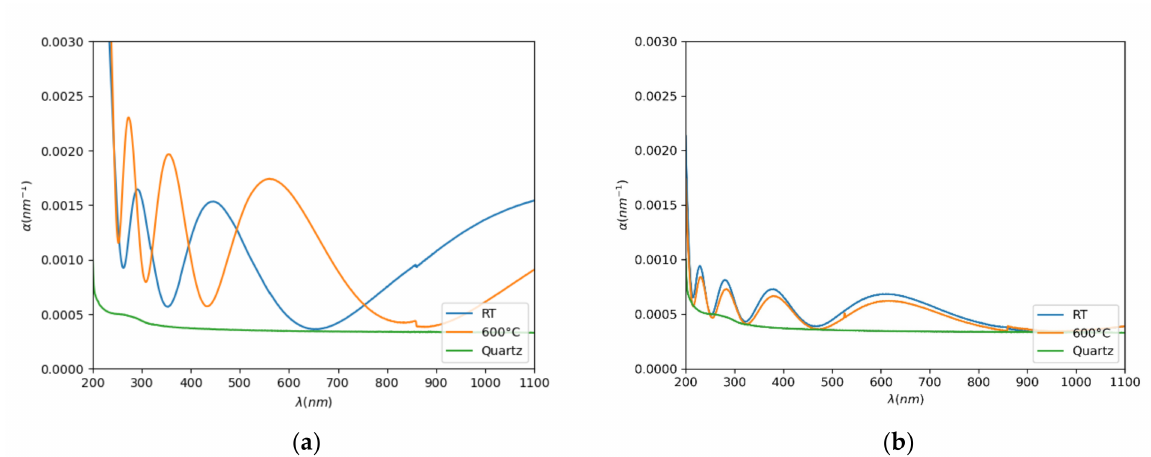
Figure 7. The absorption spectra of ( a ) hafnium silicate ( b ) aluminium silicate.